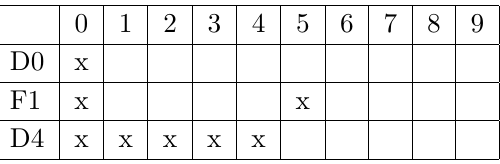
Table 4 . 1 -BPS intersection involving D0, D4 and F1 branes. A N = 4 supersymmetric quan- 8 tum mechanics lives in the common x 0 direction. ( x 1 ; : : : ; x 4 ) span the directions on the CY 2 . x 5 is the direction along the (cid:26) -interval. The ( x 6 ; : : : ; x 9 ) directions enjoy an SO(4) rotational sym- metry, of which an SU(2) is the R-symmetry of the SU(1 ; 1 j 2) supergroup and another SU(2) a global